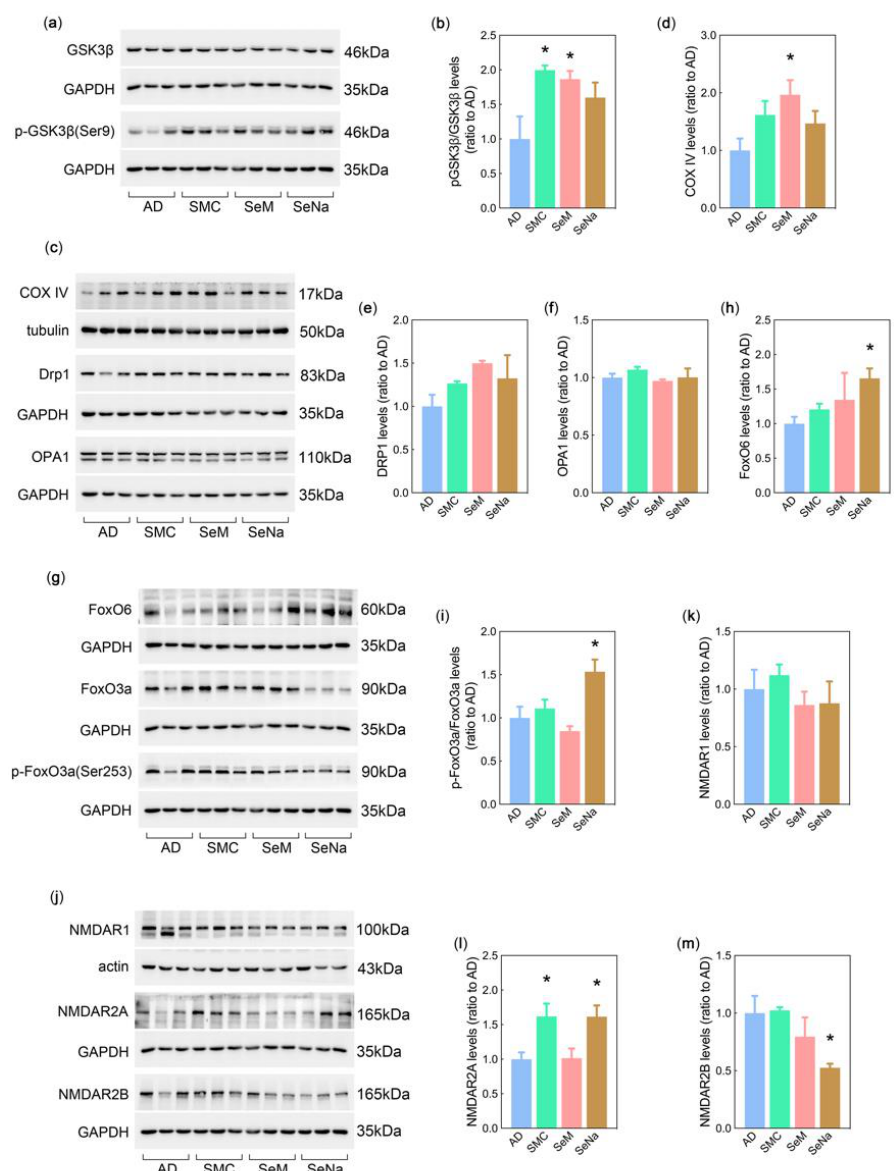
Figure 5. Levels of key proteins, kinases, and receptors in the signaling pathways related to AD pathologies. ( a ) Levels of GSK-3 β and phosphorylated GSK-3 β (Ser9) in the cortexes of 3 × Tg-AD mouse brains were analyzed by Western blotting. ( b ) Quantification of protein levels in ( a ). ( c ) Levels of COX IV, Drp1, and OPA1 were analyzed by Western blotting. ( d – f ) Quantification of protein levels in ( c ). ( g ) Levels of FoxO6, FoxO3a, and phosphorylated FoxO3a (Ser253) were analyzed by Western blotting. ( h , i ) Quantification of protein levels in ( g ). ( j ) Levels of NMDAR1, NMDAR2A, and NMDAR2B were analyzed by Western blotting. ( k – m ) Quantification of protein levels in ( j ). α -Tubulin, β -actin, or GAPDH were used as loading controls. All data are presented as the means ± SEMs ( n = 3). * p < 0.05 vs. AD mice, as determined by one- way ANOVA followed by Dunnett’s multiple comparison test.